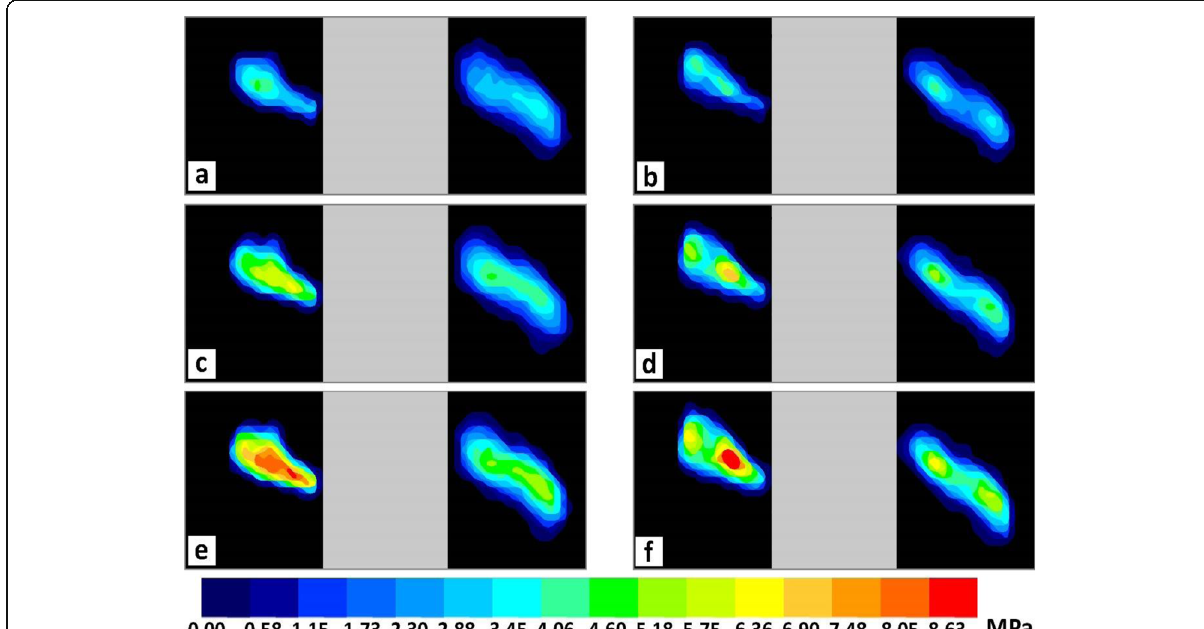
Fig. 12 Contact pressure distributions in the knee joint under different loads, a 800 N without implant, b 800 N with implant, c 1200 N without implant, d 1200 N with implant, e 1600 N without implant, f 1600 N with